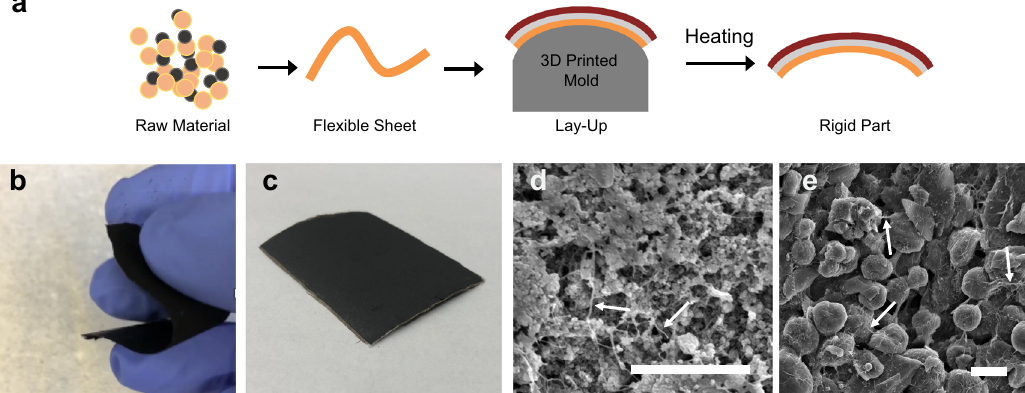
Fig. 5 Layup based manufacturing process. a Flexible sheets are produced from active materials, formed into the desired shape, then sintered to produce the fi nal part. b Flexible LFP sheet used in lay-up based fabrication of the full cell stack. c Full cell stack with curvature shaped using 3D-printed aluminum mold, scale bar 2 cm. d – e scanning electron micrographs of LFP ( d ) and graphite ( e ) electrodes with carbon nano fi ber reinforcement, scale bars 2 µ